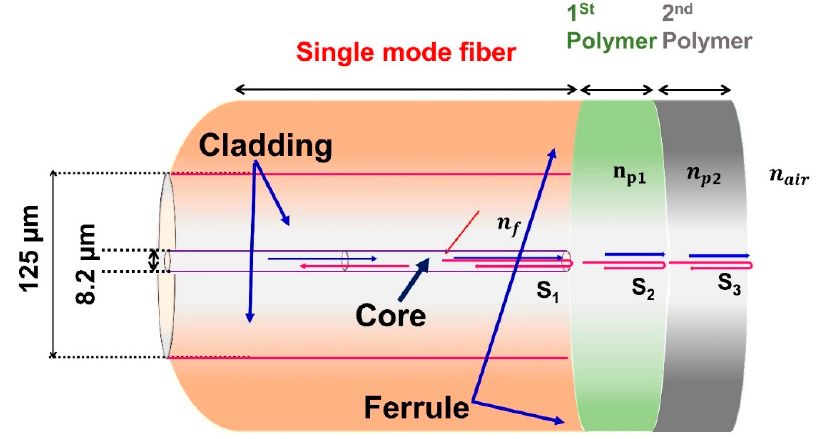
Figure 1. Schematic view of the DPFPI temperature sensor fiber ferrule connector tip.